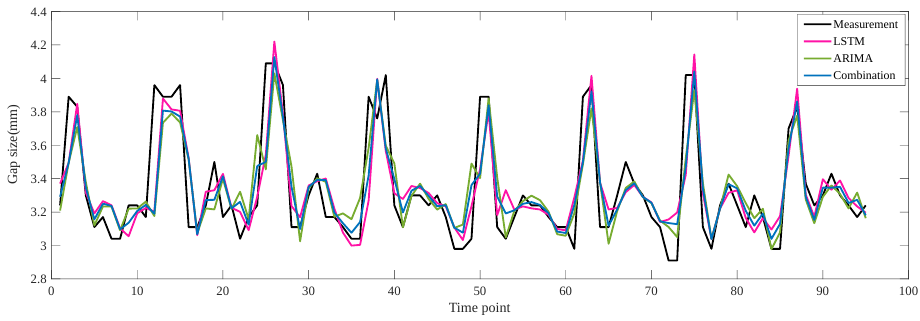
Figure 7. The prediction results of three models.